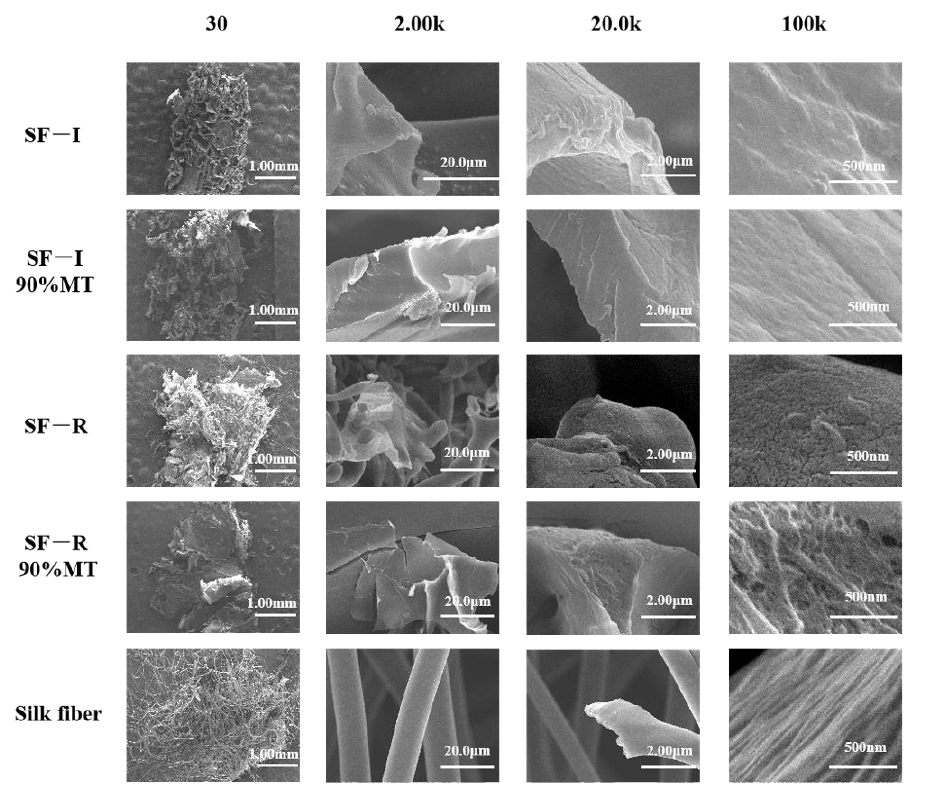
Figure 5. Scanning electron microscope (SEM) images of silk fibroin materials (SF-I and SF-R) before and after 90% methanol ( v / v ) treatment.